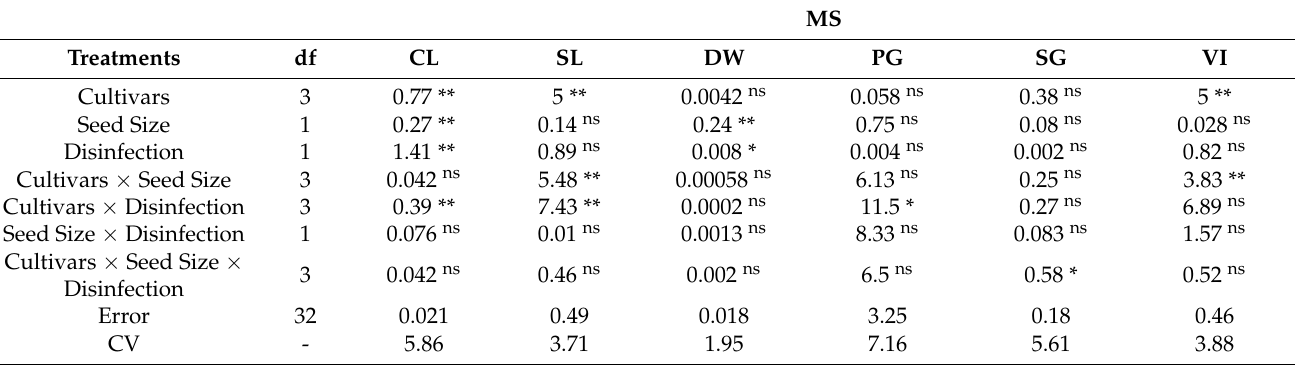
Table 2. Effect of cultivar, seed size, and seed disinfection on wheat germination traits.